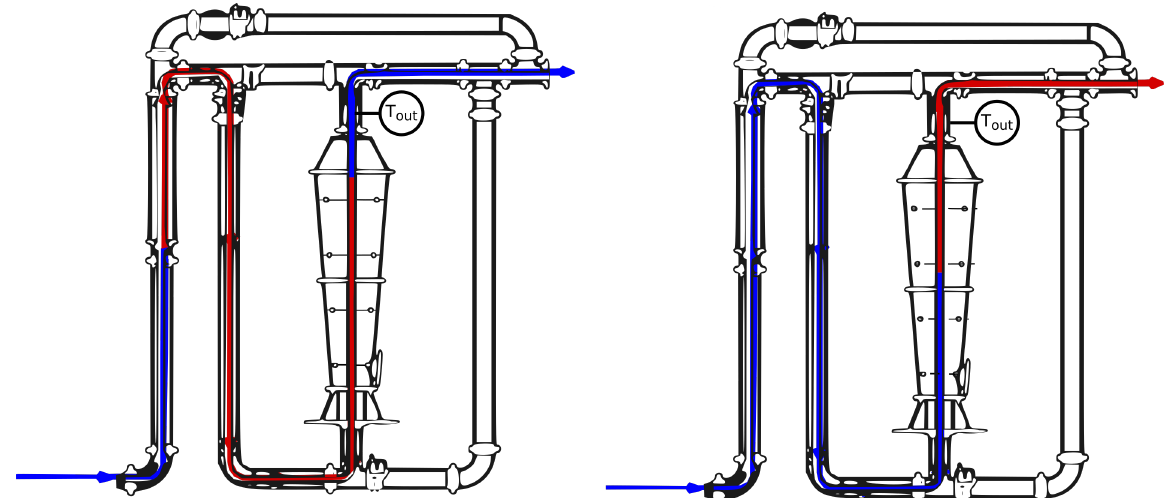
Figure 6. Bulk container of the Packed Bed Thermal Energy Storage (PBTES) installed at the laboratory in load and unload